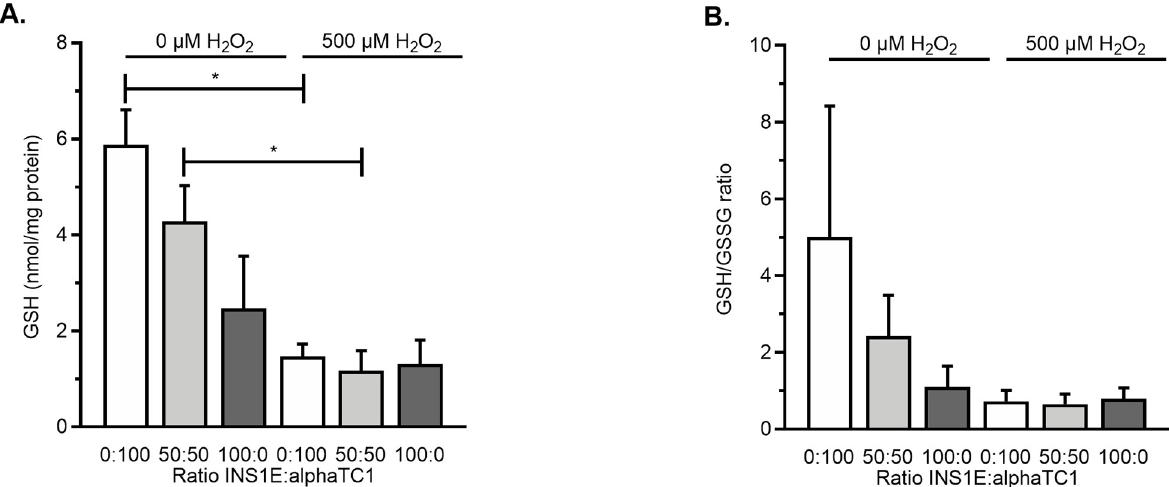
Fig 3. Intracellular GSH and GSH/GSSG ratio in monolayer cultures upon induced oxidative stress. A) Exposing the monolayer cultures of 0:100, 50:50 and 100:0 INS1E:alphaTC1 cells to 500 μ M H 2 O 2 only induced a significant decrease in intracellular GSH compared to a monolayer culture not exposed to H 2 O 2 in the ratios of 50:50 and 0:100 INS1E:alphaTC1. B) GSH/GSSG ratio in monolayer culture of 0:100, 50:50 and 100:0 INS1E:alphaTC1 cells exposed to 0 and 500 μ M H 2 O 2 showed a similar trend. N = 3, n = 2 and data are presented as mean ± SEM; � p � 0.05, all p- values are shown in S7